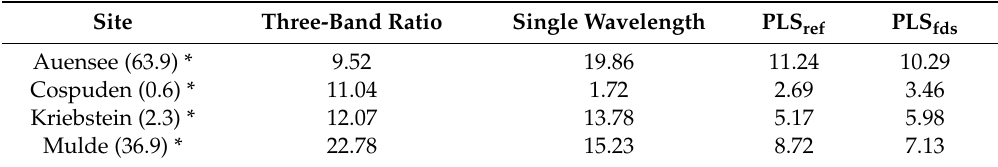
* Values in parentheses represent measured CHLa mean concentrations (in µ g L − 1 ) of the